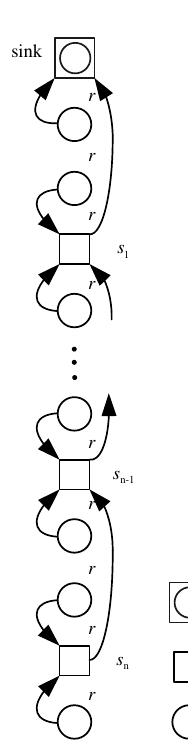
Figure 5. Two-tier hierarchical